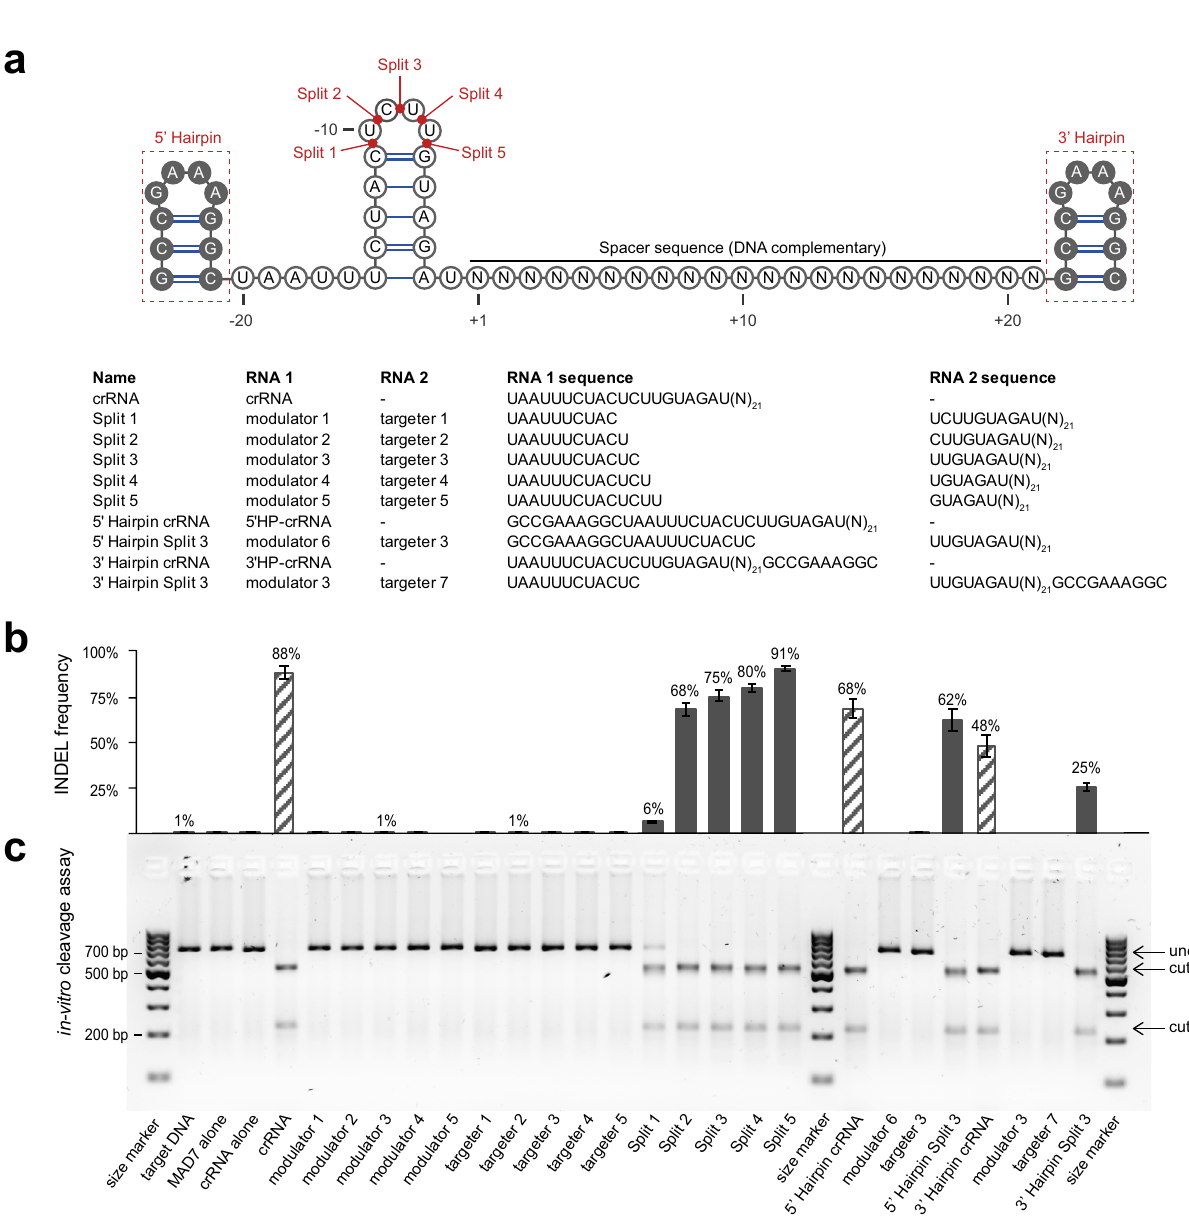
Figure 1. SynThetic trAcer RNAs (STARs) modulate gene editing in mammalian cells. ( a ) Structure and sequence of SynThetic trAcer RNAs (STARs). ( b ) INDEL frequency (%) of MAD7 with wild-type crRNA, individual STAR components, and Split STAR-crRNAs targeting the DNMT1 locus, measured by amplicon sequencing (error bars: mean ± SEM for n ≥ 3). ( c ) In-vitro cleavage assay on the amplicon containing the DNMT1 locus target sequence, size marker: GeneRuler 100 bp DNA Ladder (ThermoFisher Scientific), cropped image. Original gel image is presented in Extended Data ( c ). The sequences of all crRNAs used are listed in Supplementary Table